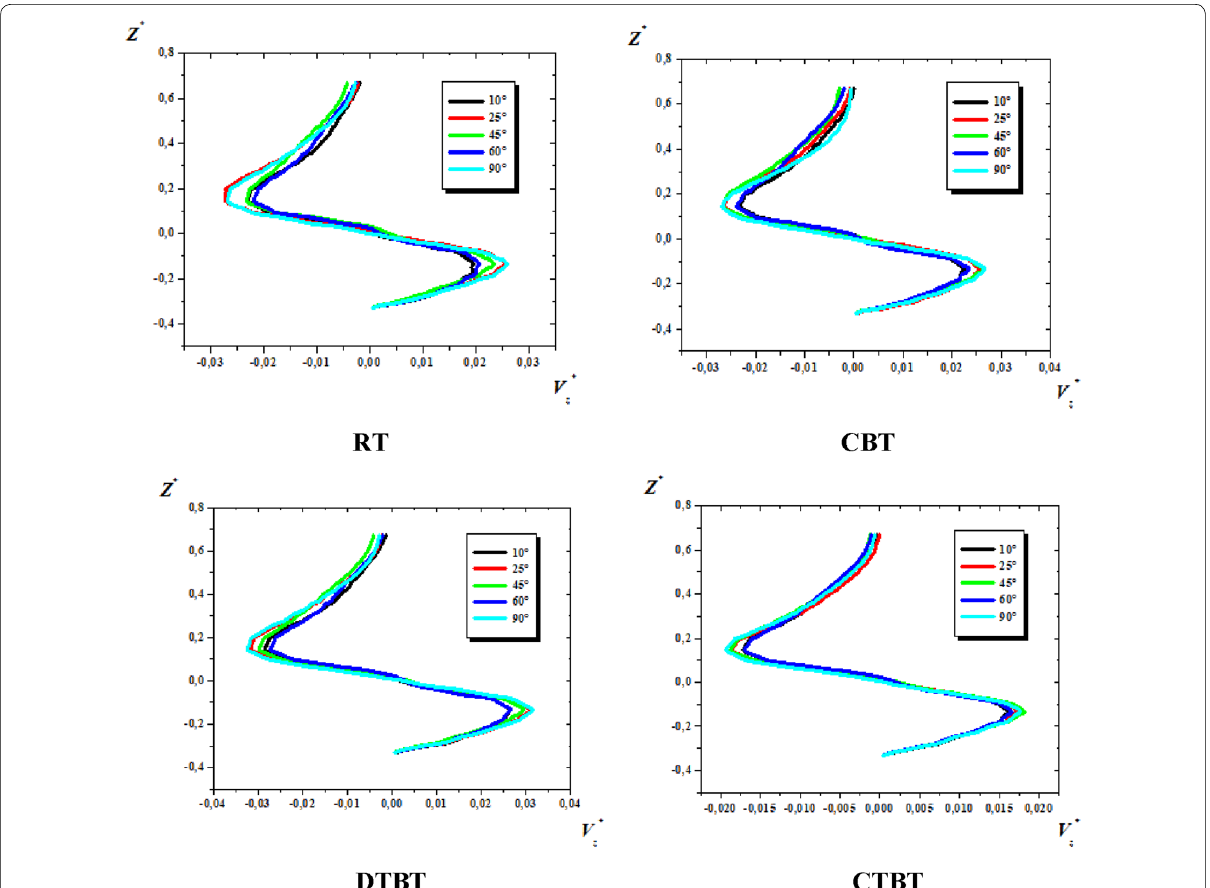
Figure 17 Axial velocities for different agitator’s types with various impeller angles along the vessel radius, at R *